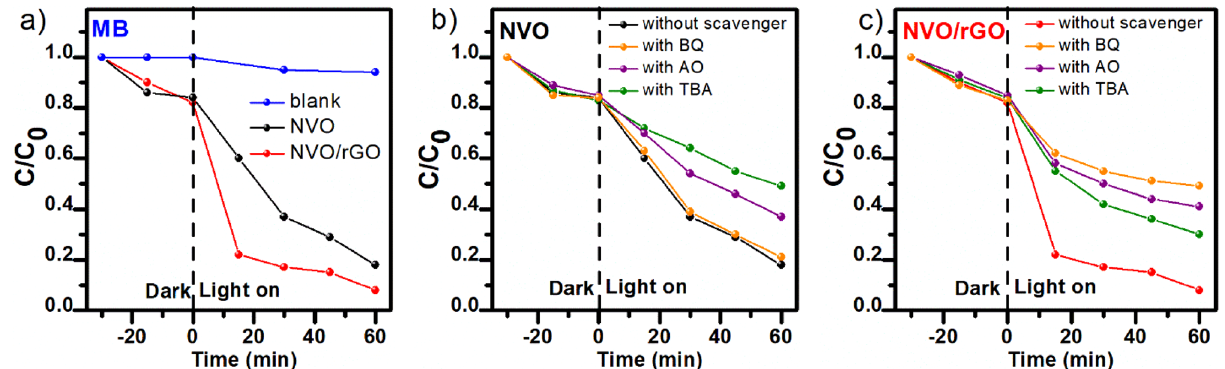
Figure 5. Photocatalytic degradation of MB under simulated solar light: ( a ) C/C 0 vs t plot and ( b , c ) active species trapping experiments with the addition of BQ, AO, and TBA as scavengers for O2- radicals, holes h + , and hydroxyl radicals ·OH,